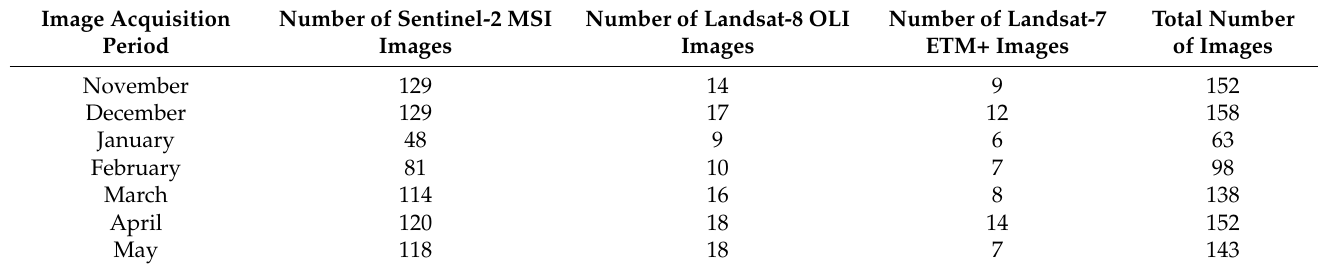
Table 4. Number of images available for each month in Jiangsu